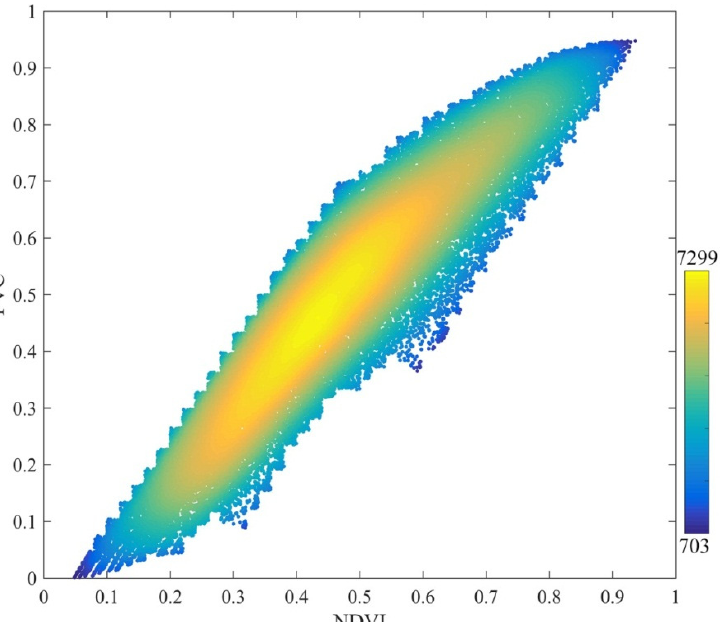
Figure 3. The distribution of the density scatter plots of the refined NDVI and FVC samples (the density value of each NDVI–FVC sample point was calculated by counting the number of splattering over a center circular area with a 0.1 length of the radius [66]).